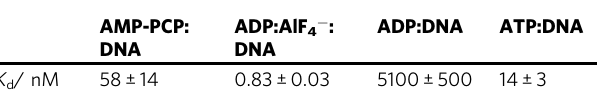
Table 1 ADP:AlF 4 − is the best binder for DNA AMP-PCP: DNA Overview of dissociation constants for the ssDNA bound complexes for the different nucleotide bound states along the motor cycle. The fi t parameters are given in Supplementary Table